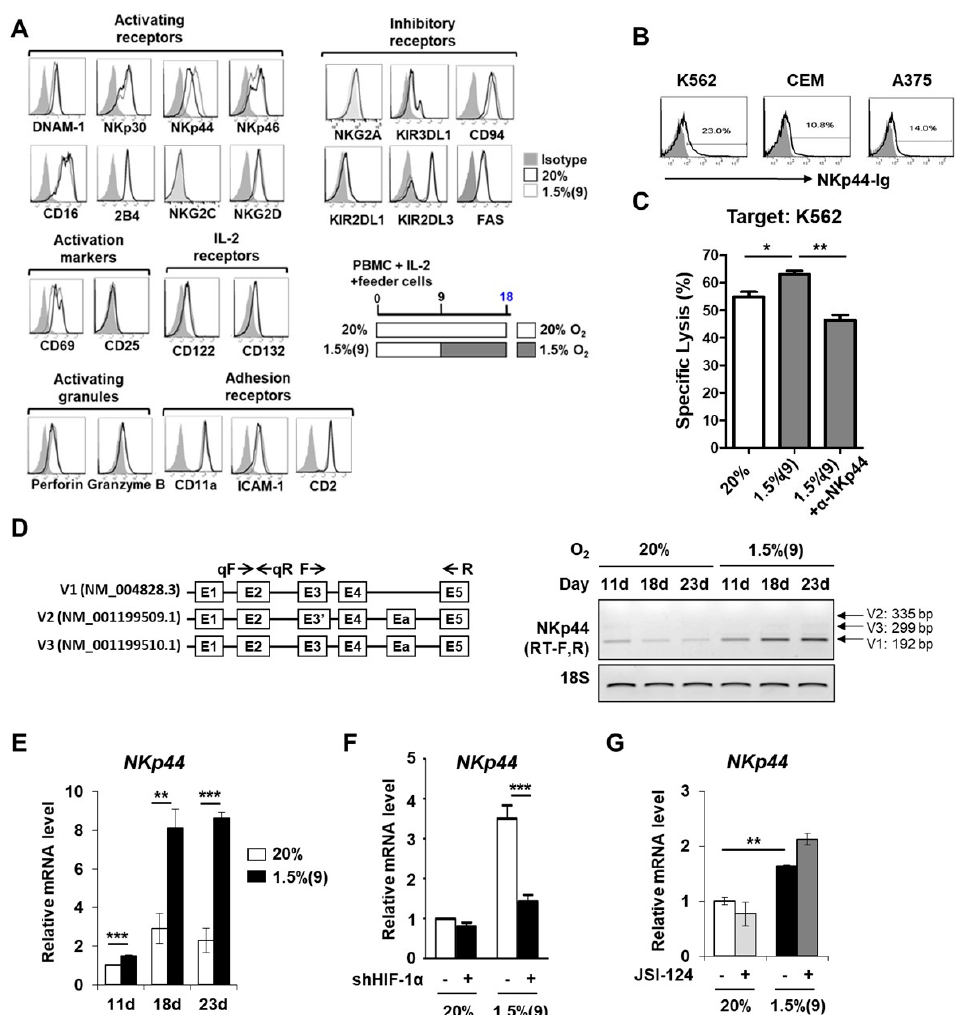
Figure 7 . Pre ‐ activated hypoxic NK cells demonstrate high NKp44 expression on the cell surface. ( A ) Surface expression of various receptors was assessed by flow cytometry of NK cells. For each receptor, analysis was performed on CD56 + CD3 ‐ subsets across the whole population. Data shown are representative of four independent experiments. ( B ) Cell surface expression of NKp44L was assessed by flow cytometry. The indicated tumor cell lines were stained with NKp44 ‐ Ig fusion protein (black) or controls (gray). ( C ) Tumor killing assays were conducted using ex ‐ vivo expanded NK cells under normoxic or hypoxic conditions for 18 days. Where indicated, pre ‐ activated hypoxic NK cells were treated with blocking anti ‐ NKp44 mAbs at 5 μ g/mL during the 4 ‐ h cytotoxicity assay. Two experiments were performed , each in triplicate. ( D ) Left , diagrams showing three variants of NKp44 mRNA (V1–V3); the primer sets for qRT ‐ PCR and RT ‐ PCR are indicated as qF/qR and F/R respectively, by arrows. Right , Expression levels of three NKp44 transcription variants were analyzed by RT ‐ PCR. ( E ) mRNA level of NKp44 was quantified by qRT ‐ PCR. NK cells in PBMCs were expanded with IL ‐ 2 and feeder cells under normoxic or hypoxic conditions and then isolated. ( F ) mRNA level of NKp44 in normoxic and pre ‐ activated hypoxic NK cells is shown in presence of shHIF ‐ 1 α for 2 days (at 11 ‐ d). NK cells in PBMCs were expanded with IL ‐ 2 and feeder cells under normoxic or hypoxic conditions and enriched up to 85%. ( G ) mRNA level of NKp44 in normoxic and pre ‐ activated hypoxic NK cells, in presence of JSI ‐ 124 for 4 days (at 13 ‐ d), is shown. NK cells in PBMCs were expanded with IL ‐ 2 and feeder cells under normoxic or hypoxic conditions and enriched up to 78%. Data of ( E – G ) obtained from two independent experiments, each using PBMCs from different individual donors, are presented as the mean ± SEM. *, p < 0.05; **, p < 0.01; ***, p <